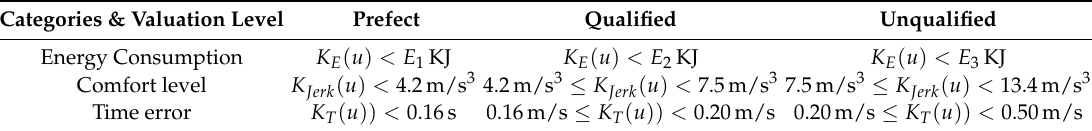
The preference categories circumstances in automatic train operation velocity trajectory